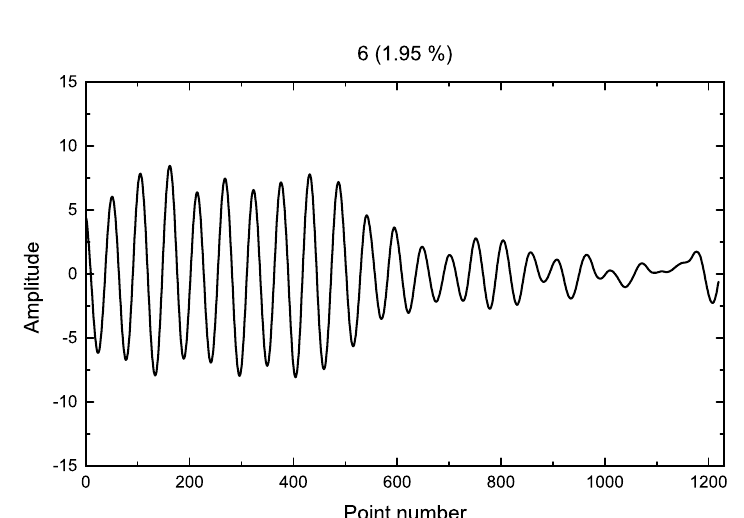
Fig. 6. Example of eigenvector (number 6) for OJ 287 at 14.5 GHz. The percentage value in brackets represents the contribution of the eigenvector in decomposition of the original